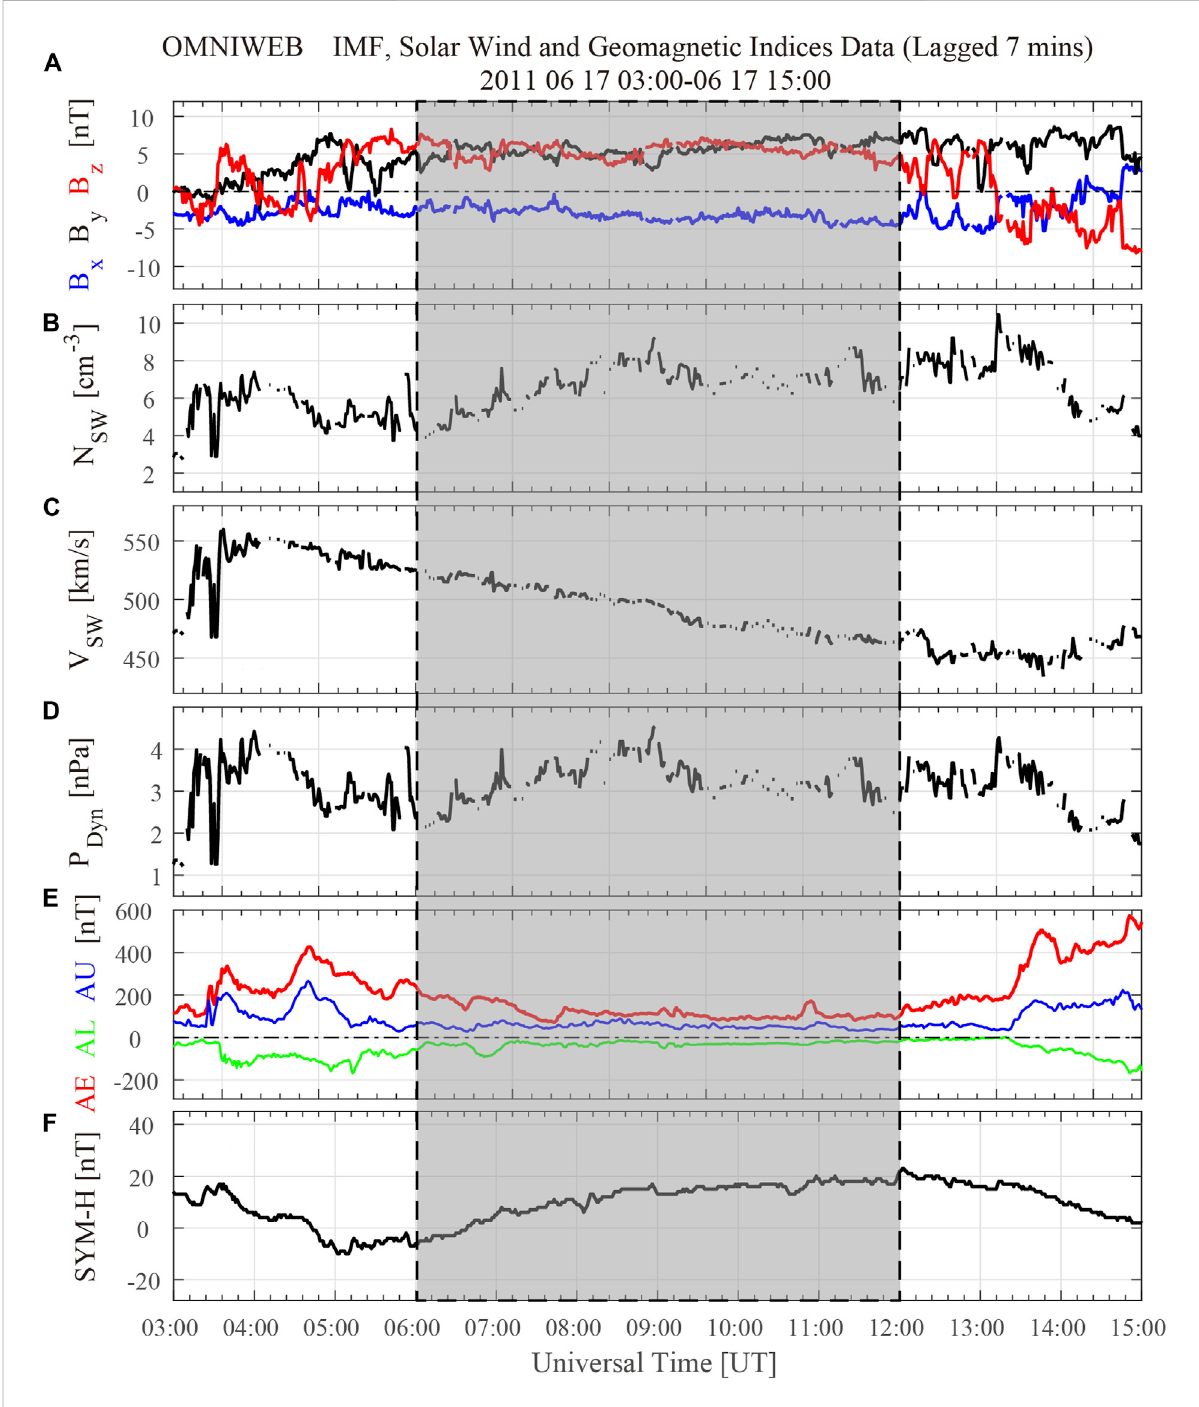
FIGURE 2 Overview of the interplanetary conditions and geomagnetic indices on 17 June 2011. (A) IMF components in geocentric solar magnetosphere (GSM) coordinates; (B) solar wind proton density; (C) solar wind speed; (D) solar wind dynamic pressure, PDyn; (E) provisional auroral electrojet indices: red, blue, and green lines are for AU, AL, and AE; and (F) provisional SYM-H geomagnetic